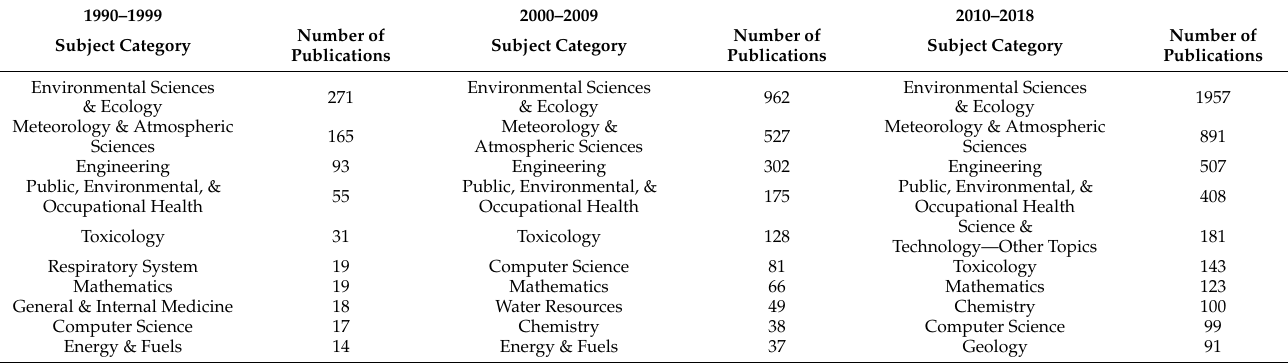
Table A2. The number of papers in the field of air pollutant prediction published by the 10 journals that were most active in publishing studies in this field during three periods.